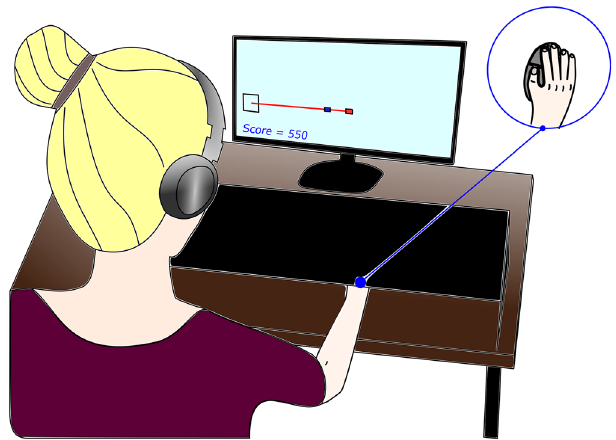
Figure 7. Experimental setup. Participants controlled a blue cursor on a screen using a computer mouse. Endpoint only feedback was provided after each movement was completed. See Methods for detailed description of equipment and protocol.